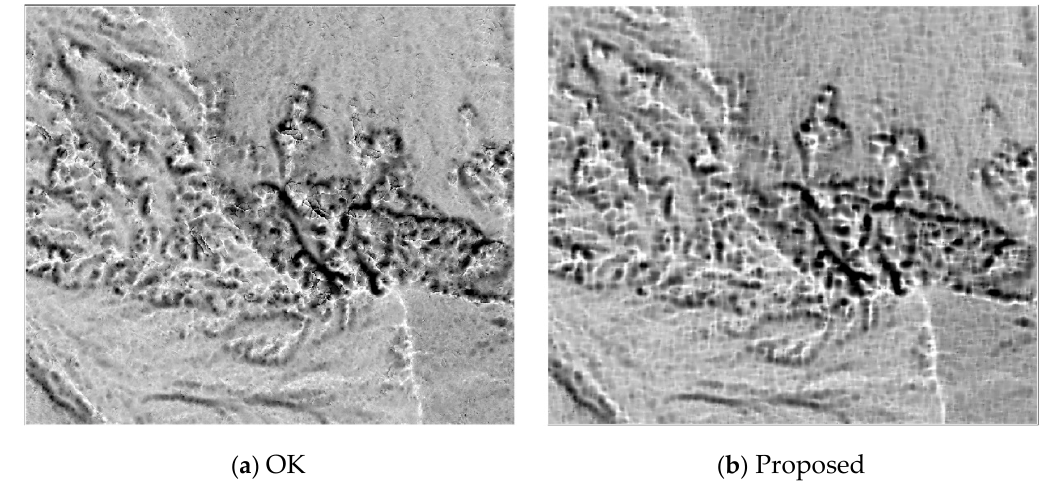
Figure 12. Positive openness maps of ( a ) OK and ( b ) the proposed method.